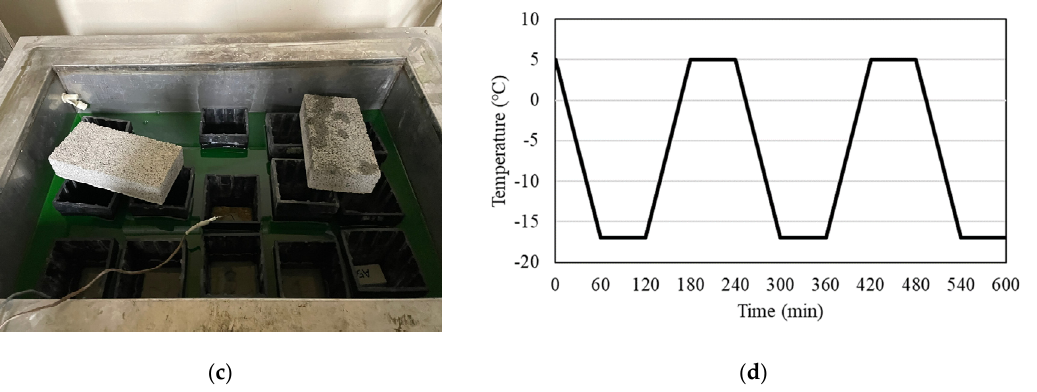
Figure 1. Specimen preparation and mechanochromic sensor attachment. ( a ) Details of direct tensile test specimen manufacturing process and specimen; ( b ) surface condition with mechanochromic sensor attached to cement composite; ( c ) freeze—thaw test; ( d ) temperature cycling from − 18 to 4 °C for 300 cycles. Table 1. Mechanical properties of the materials used.